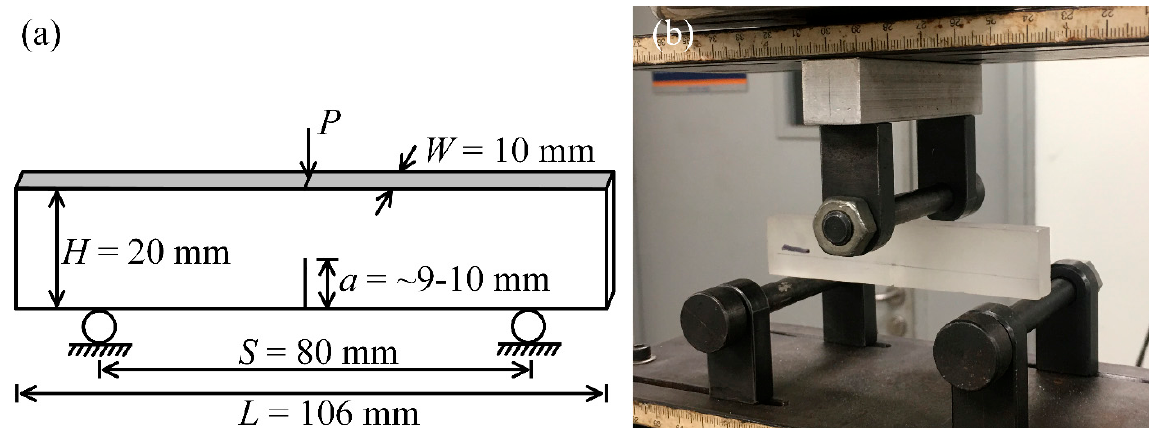
Figure 2. Schematic diagram showing ( a ) the three-point end notch bending (3P-ENB) test for the single edge notched bend (SENB) specimen and ( b ) its testing scene on a universal testing machine.